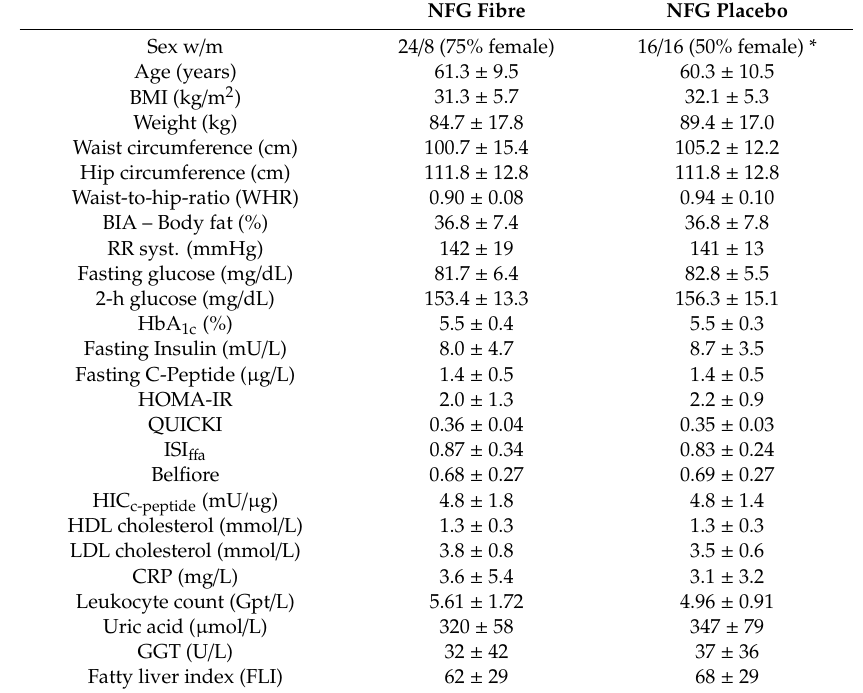
Table 1. Characteristics of participants at study entry (normal fasting glucose (NFG) subgroups